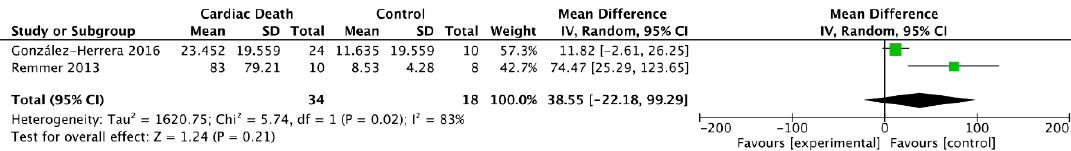
Figure 2. Forest plot of cTn I in pericardial fluid between cardiac death and control groups.